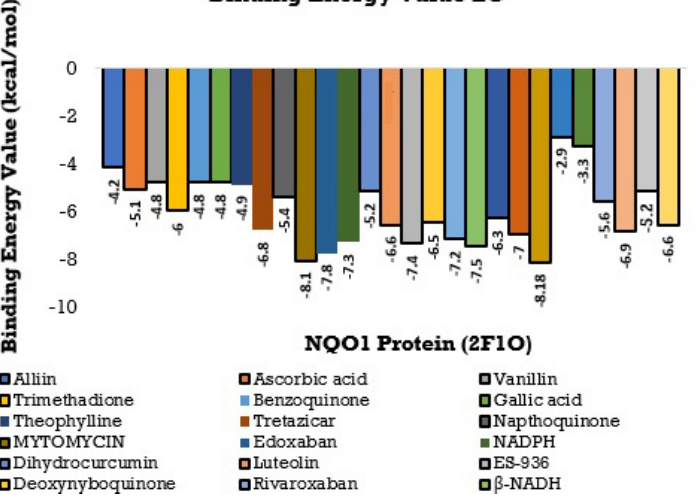
Figure 8. Histogram showing the Molecular Docking results between NQO1 (2F1O) against selective phytobioactives (the binding energy value δ G is shown in minus kcal/mol).